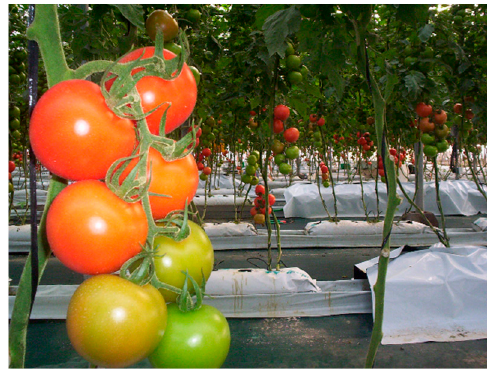
Figure 4. Lower part of the crop with mature tomatoes.